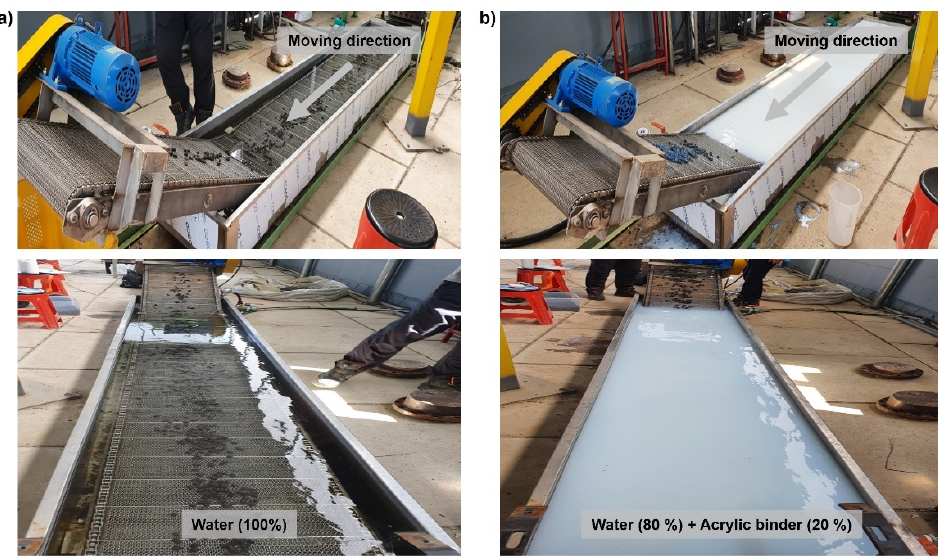
Figure 8. Photograph of the recycled plastic film-based aggregates production line ( a ) without and ( b ) with surface treatment.